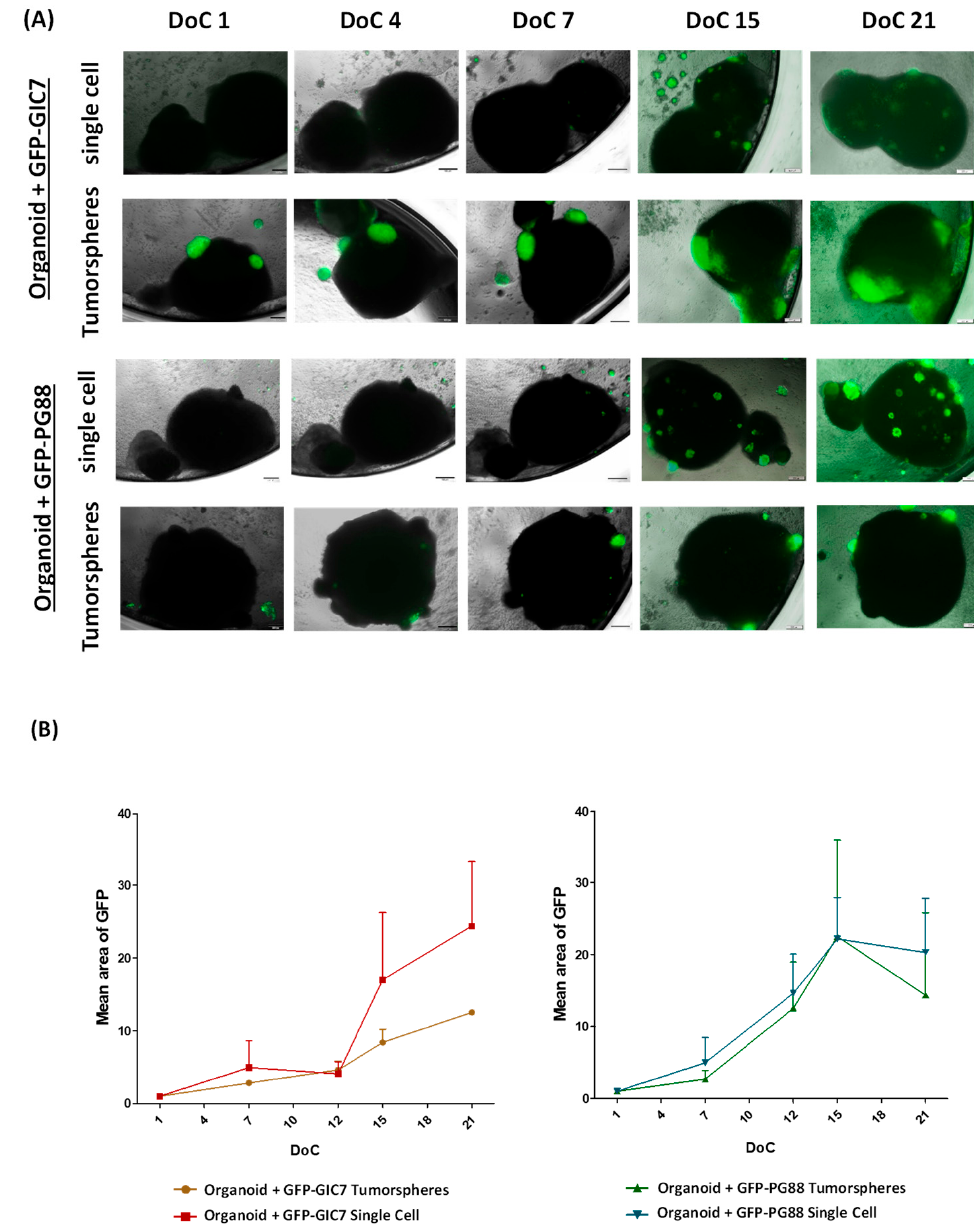
Figure 4. Study of the tumor engraftment effectiveness. ( A ) Merge of fluorescence and phase-contrast images of GFP-GIC-organoid co-cultures at days 1, 4, 7, 15, and 21 after the engraftment (DoC). Both GFP-GIC7 (top panels) and GFP-PG88 (bottom panels), seeded as tumorspheres or as a single cell, as indicated, achieve infiltration of the organoid generating a viable tumor. Both GFP-GICs grew around and inside the organoid. Images at 4 × obtained with Microscope Olympus IX51 are shown. Scale bar 200 µ m. ( B ) Semi-quantitative analyses of tumor growth expressed as the mean of tumor area (GFP positive area), concerning the total organoid, evaluating GFP fluorescence of GFP-GIC7 (left) and GFP-PG88 (right) seeded as tumorspheres or single cells. To normalize the data and homogenize the different co-cultures, the initial GFP fluorescence on DoC 1 was used to evaluate each well and to compare the GFP area. The data are representative of the tumor engraftment effectiveness of both GFP-GICs. An ANOVA test was used to compare the means of 4 different conditions for every DoC and each situation for every DoC vs. the first DoC. DoC = Days of